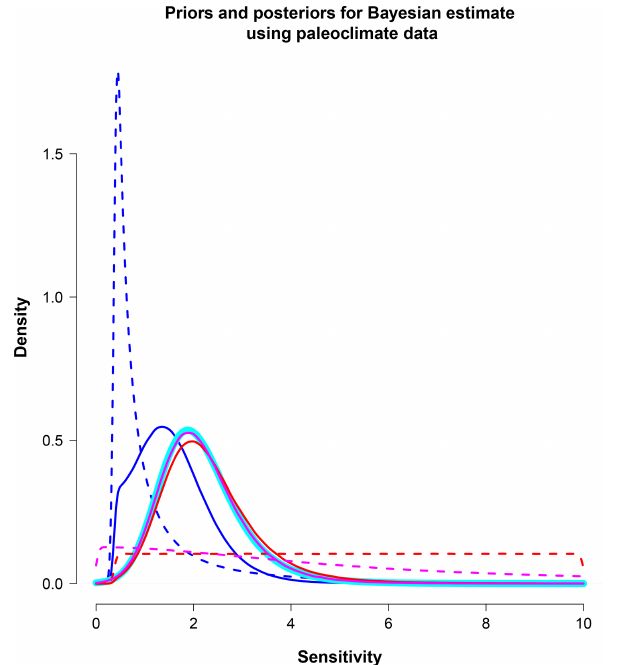
Figure 1. Prior and posterior estimates for the climate sensitivity arising from paleoclimatic evidence. Dashed lines show priors, and solid lines are posterior densities. The thick cyan line shows the posterior estimate arising from the method of sampling observa- tional PDFs, with the corresponding prior shown in Fig. 2. Blue lines represent results using a uniform prior in λ ; red is uniform in S , and magenta is half-Cauchy (scale: 5) in S (and therefore also half-Cauchy in λ ; scale: 3 . 7 /